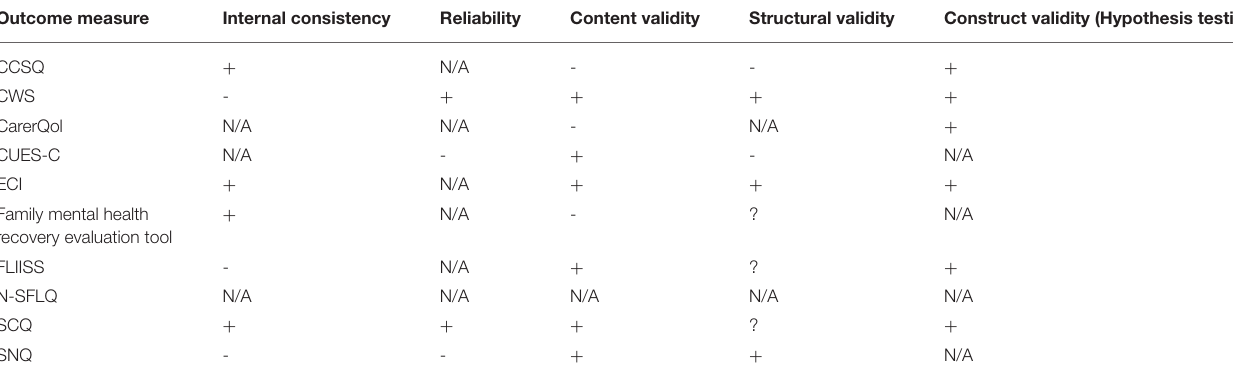
TABLE 4 | Quality of measurement properties per self-report